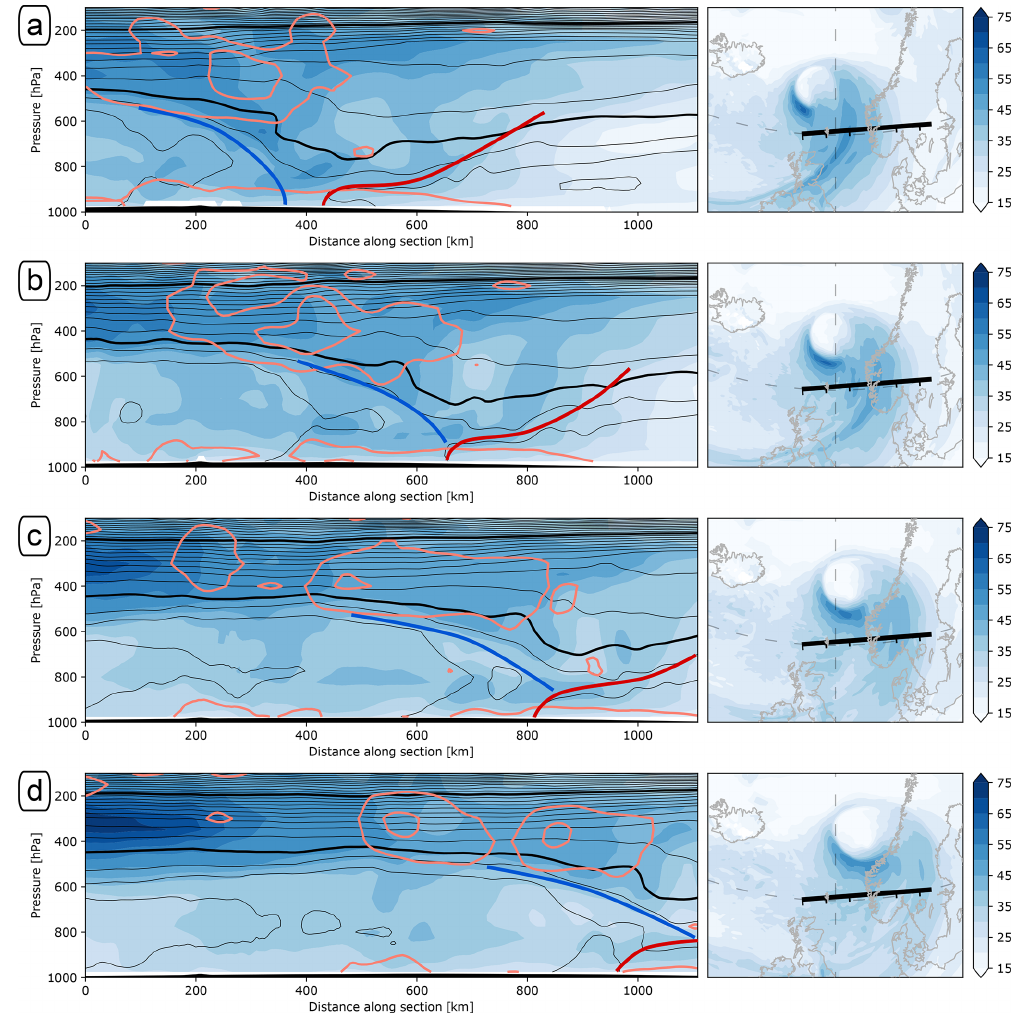
Figure 10. Cross section of wind speed (shading, ms − 1 ), equivalent potential temperature (black contours with intervals 5, 300, and 350K thickened) and ageostrophic horizontal wind with contours at 15, 25, and 35ms − 1 . The blue and red lines mark subjectively analysed cold and warm fronts, respectively. The maps in the right column show wind speed at 850hPa as well as the location of the cross section with ticks every 200km. The rows show (a) 03:00UTC, (b) 05:00UTC, (c) 07:00UTC, and (d) 09:00UTC on 1 January 1992 for the Ocean